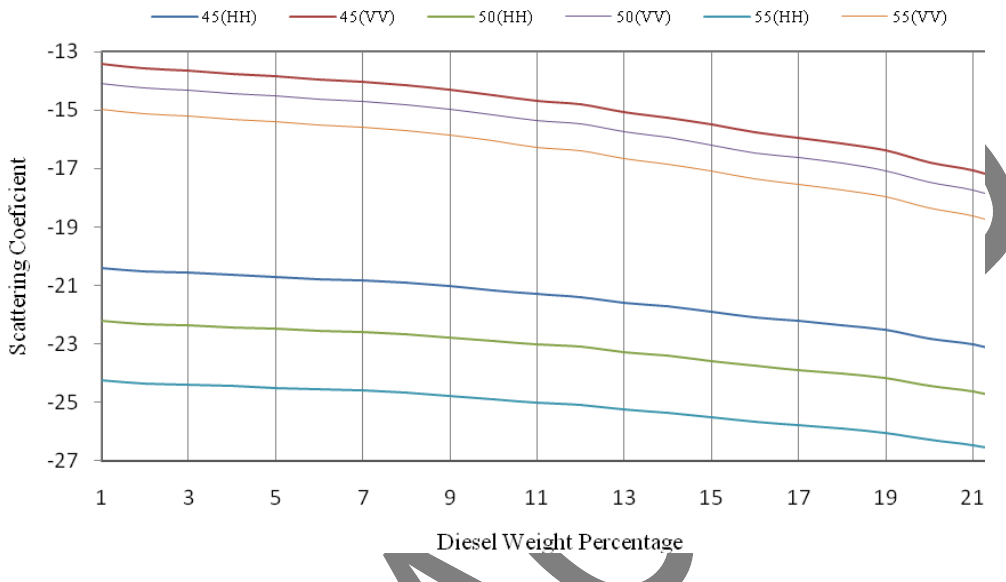
Figure 8. Variation of the scattering coefficient of soil with different weight percentages of diesel in three different angles (45, 50 and 55) degree.